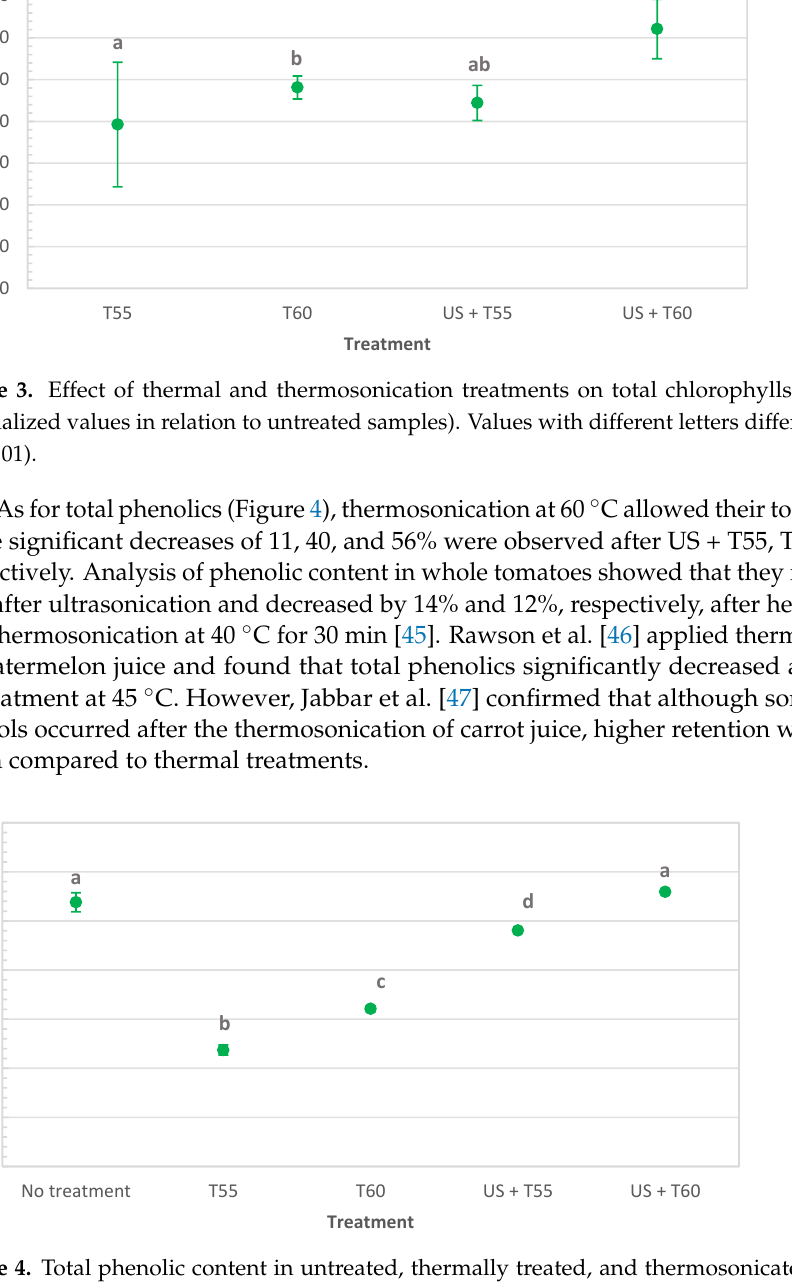
Table 2. Mineral composition of untreated and thermosonicated kiwi peel.